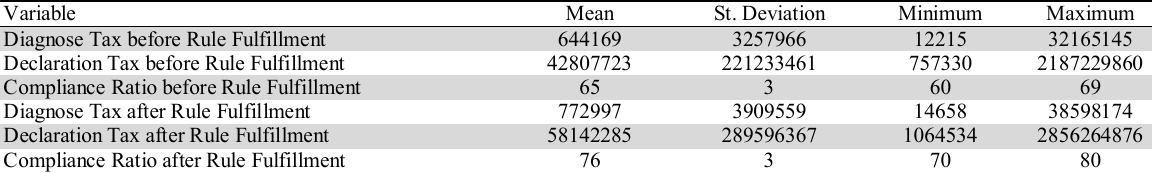
The Summary of Compliance Criteria